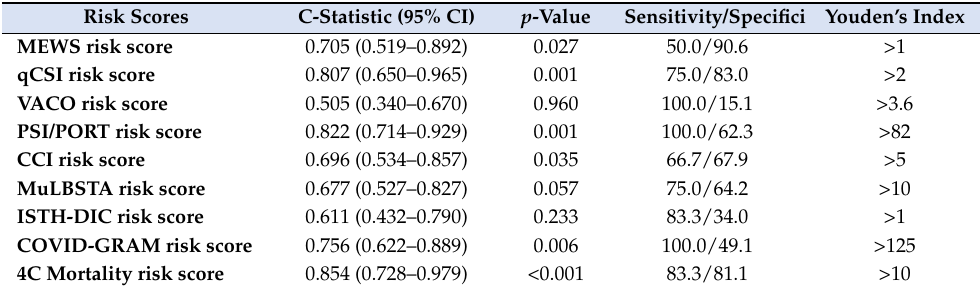
Abbreviations : 4C Mortality Score—Coronavirus Clinical Characterisation Consortium Mortality Score; CCI—